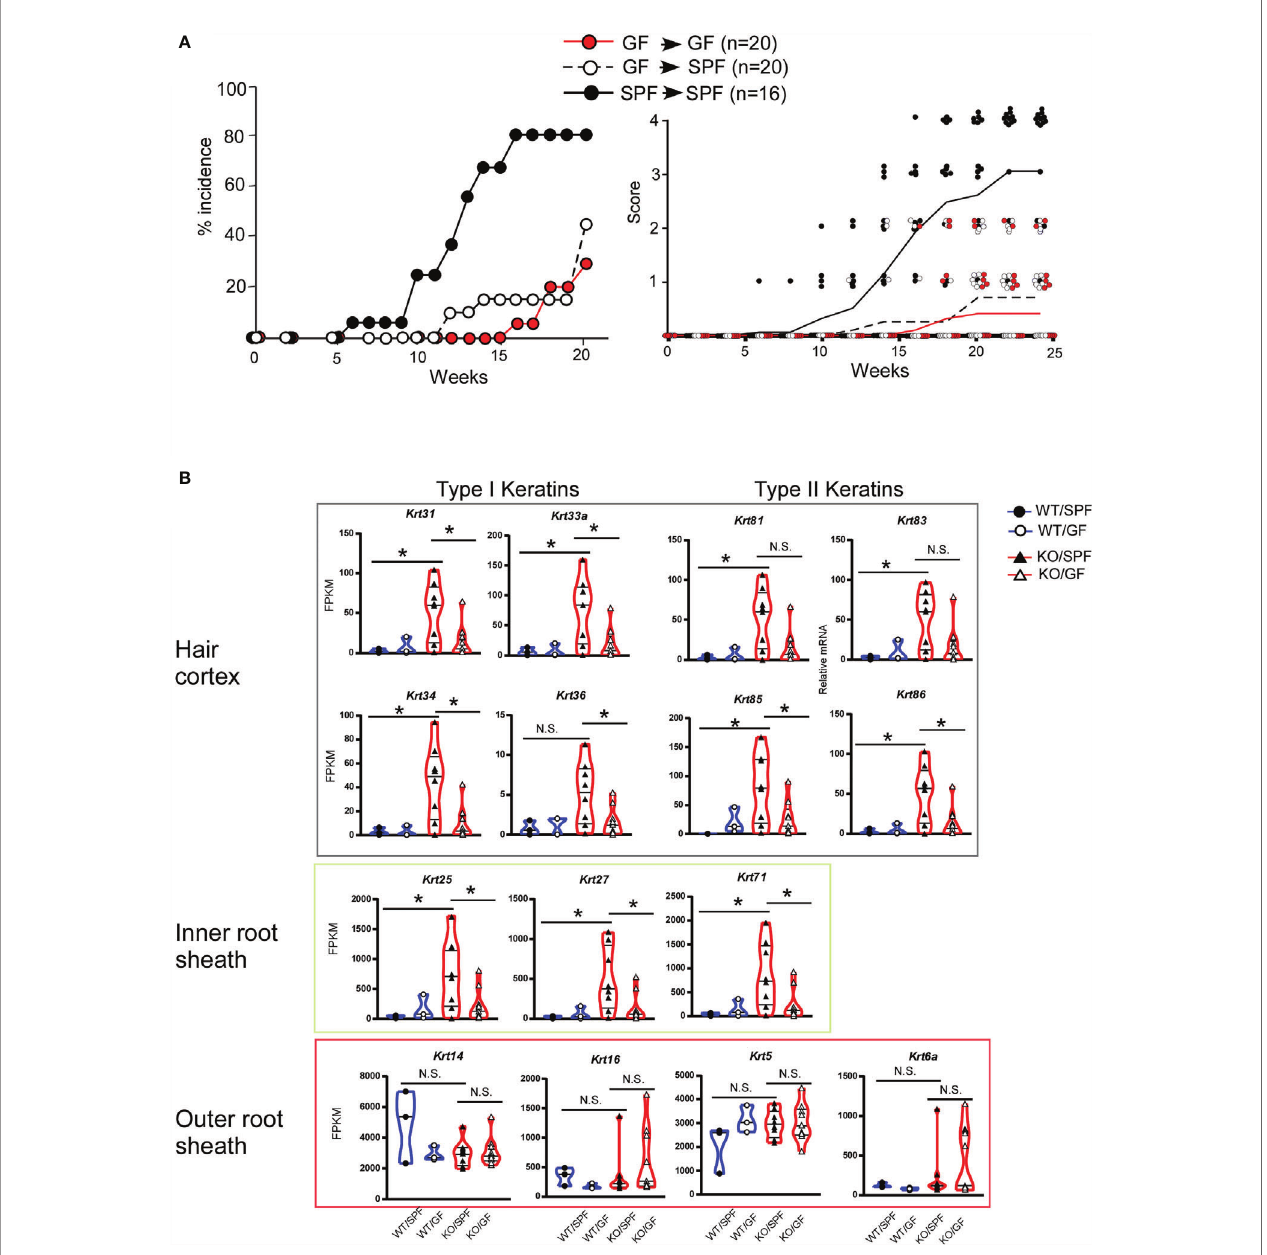
FIGURE 5 | Gene expression pro fi les of hair follicle (HF)-speci fi c keratin in ear skin from Stat3 D K5 mice in germ-free (GF) conditions. (A) The effect of changing the breeding environment on dermatitis onset was evaluated under speci fi c-pathogen free (SPF) and GF conditions. Mixed background Stat3 D K5 (KO) mice born in GF conditions were divided into two groups at 4 weeks of age and maintained in either SPF (white dots) or GF (red dots) conditions. Black dots show data from KO mice raised in SPF conditions for life. The data indicate the percent incidence of dermatitis at the indicated weeks of age (left). The clinical scores for GF (red dots and line, n=20), GF-SPF (white dots and black dotted line, n=20), or SPF (black dots and solid line, n=16) conditions were analyzed in mixed-background Stat3 D K5 mice at the indicated time points (right). Lines indicate means of clinical scores in each group. (B) The expression pro fi les of HF-speci fi c keratins in the ear skin of 20- week-old WT (circles) or KO (triangles) mice raised on SPF or GF conditions. The blue and red lines in the violin plots indicate WT and KO, respectively, and closed and open marks indicate SPF and GF, respectively. *p<0.05, N.S. indicates not signi fi